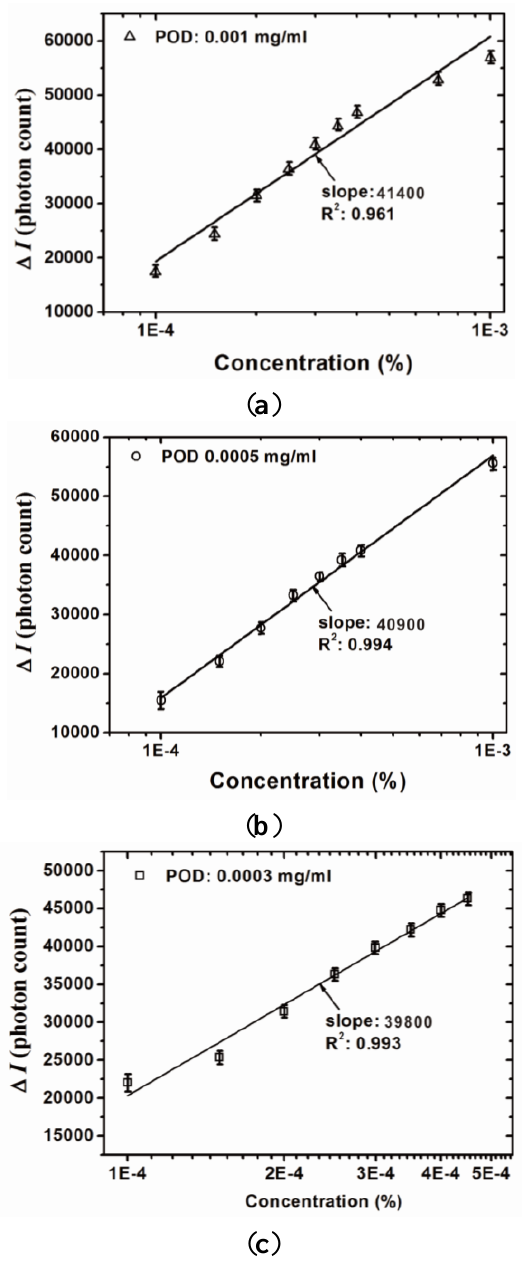
Figure 5. Calibration curve of the proposed sensor with various POD concentrations (( a ) 0.001 mg/mL; ( b ) 0.0005 mg/mL; and ( c ) 0.0003 mg/mL) at a monitored wavelength of 510